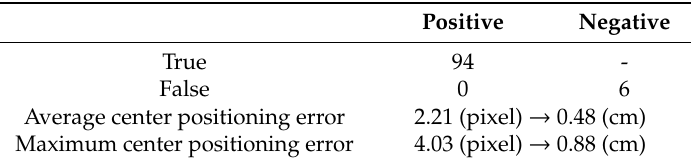
Table 3. The classification results.